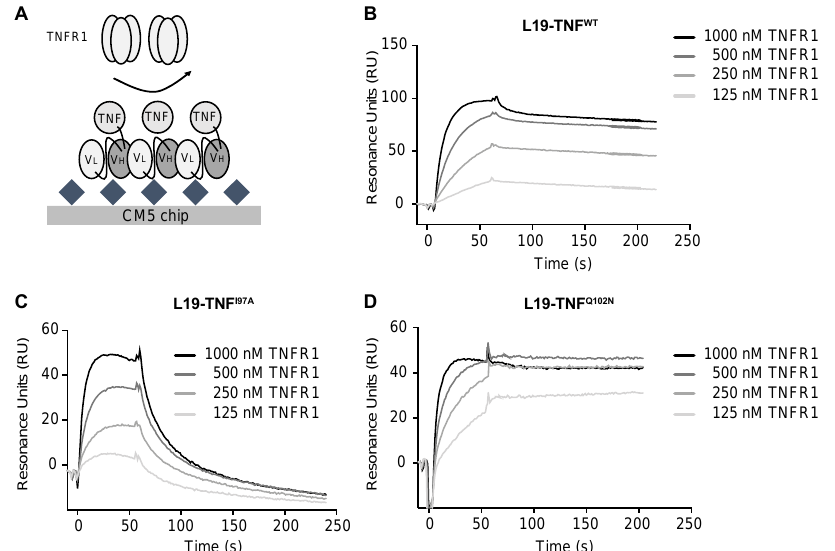
Figure 4. Real time binding analysis of TNFR1 on immobilized L19-TNF muteins. ( A ) Schematic representation of affinity measurement methodology. EDB was covalently immobilized on the chip, while different L19-TNF muteins were coated on the solid surface thanks to non-covalent L19-EDB interaction. TNFR1 was sequentially injected at different concentrations (starting concentration of 1000 nM, followed by 1:2 dilution series). SPR sensorgrams of ( B ) L19-TNF WT , ( C ) L19-TNF Q102N and ( D ) L19-TNF I97A are presented.